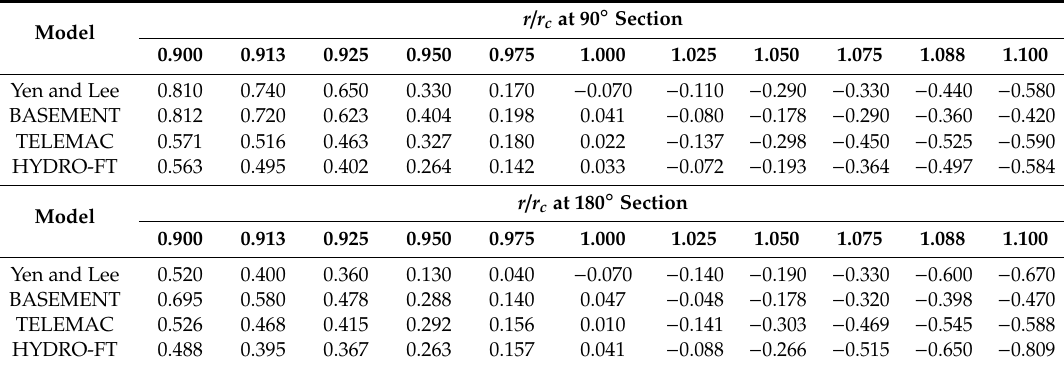
Table 4. Transverse variation of non-dimensional bed deformation ∆ z / h 0 at sections of maximum Table 5. Statistical performance of each model at 90° and 180° sections. deposition and scour (90 ◦ and 180 ◦ sections).